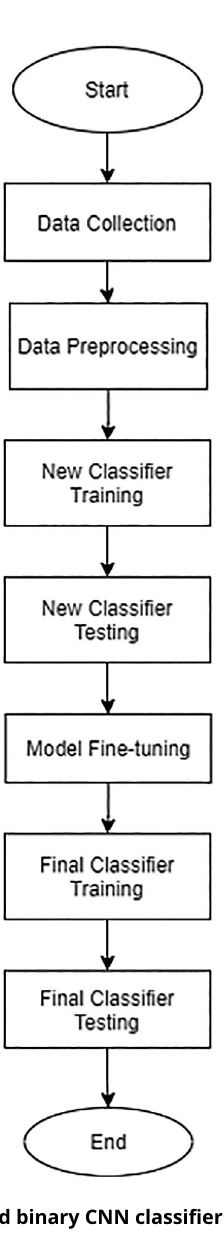
Figure 7. Flowchart of building up proposed binary CNN classifier